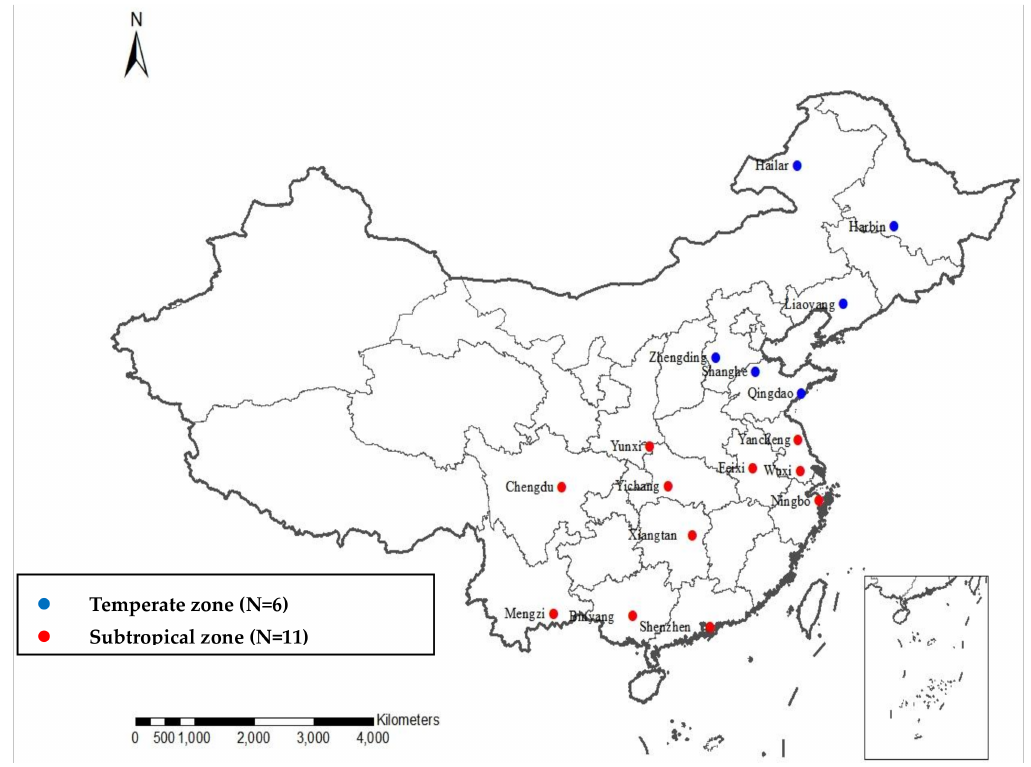
Figure 1. Geographical location of 17 study